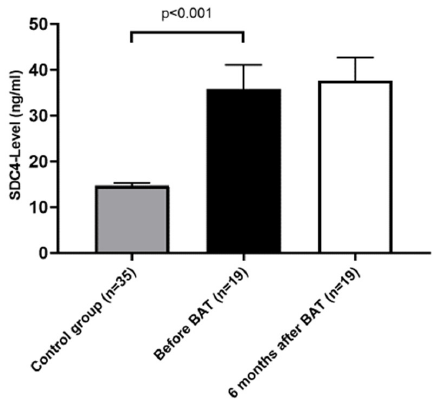
Figure 1. Serum syndecan-4 (SDC4) level is increased in patients with resistant arterial hypertension (HTN). Values are given as means ± standard error of the mean (SEM).